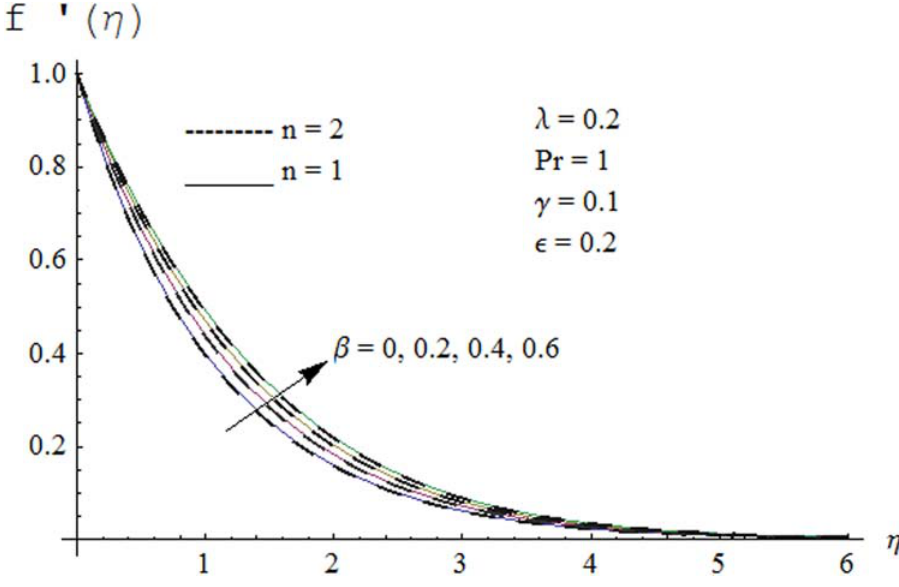
Fig 5. Effect of β on velocity profile.